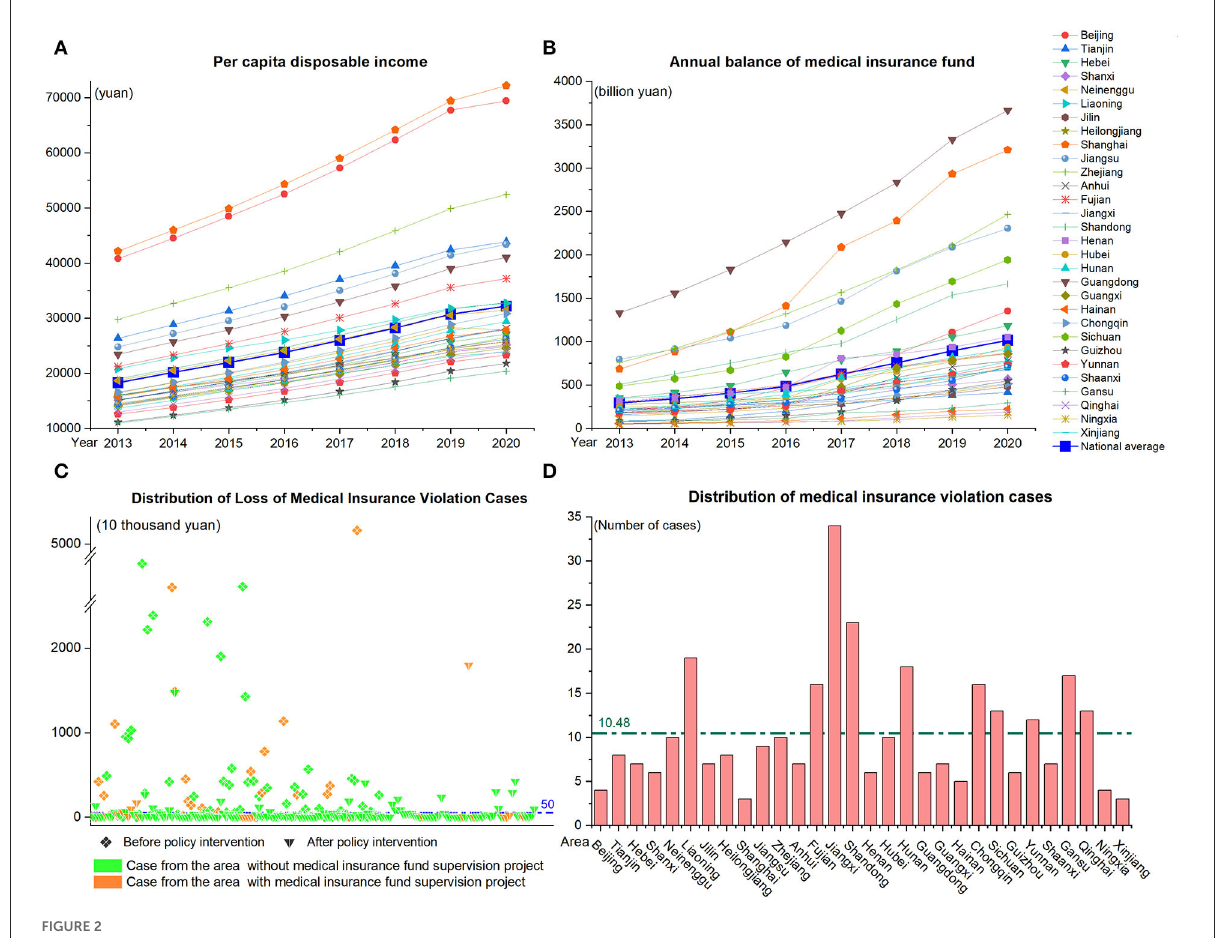
FIGURE2 (A–D) Basic information of the